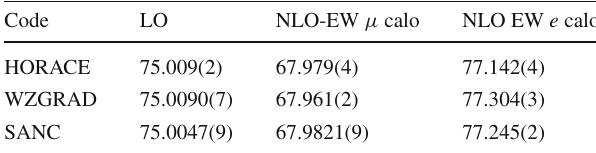
Table 18 pp → γ, Z → l + l − cross sections (in pb) at the 8 TeV LHC, with LHCb cuts and “calorimetric”